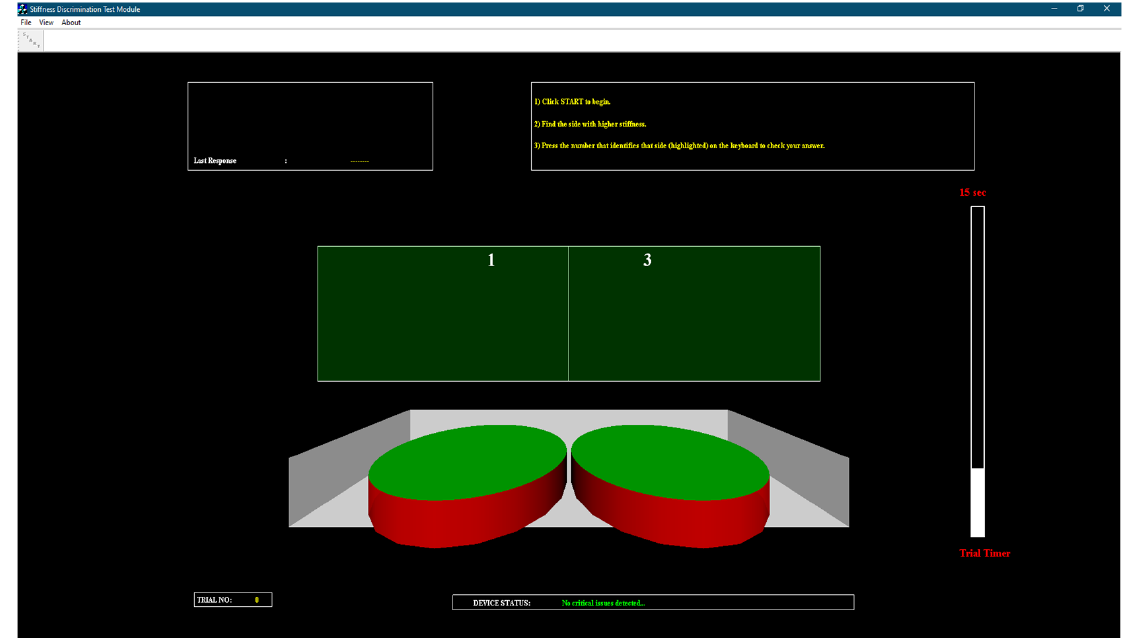
Figure 2. User interface for the stiffness discrimination task.